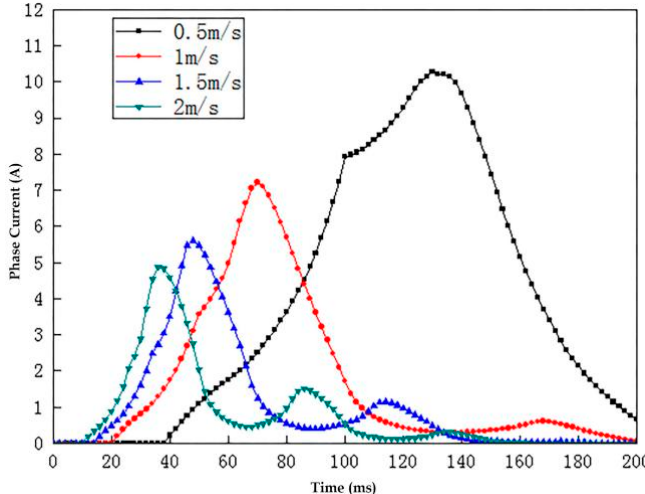
Figure 11. The phase current waveform at different speeds is shown in Figure 11. When the speed is too low, the phase current will peak.